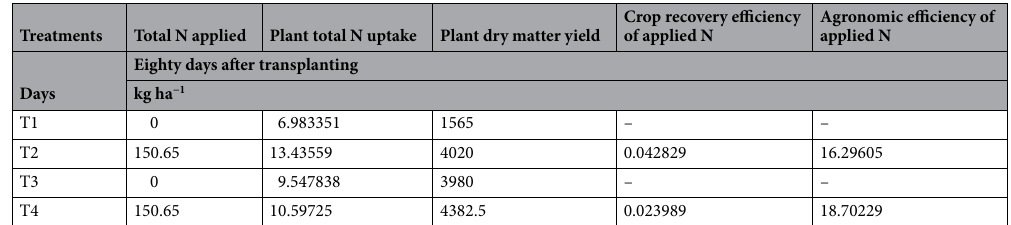
Table 21. Chicken litter biochar application and split application of urea on Crop Recovery and Agronomic Efficiency on day eighty after transplanting.